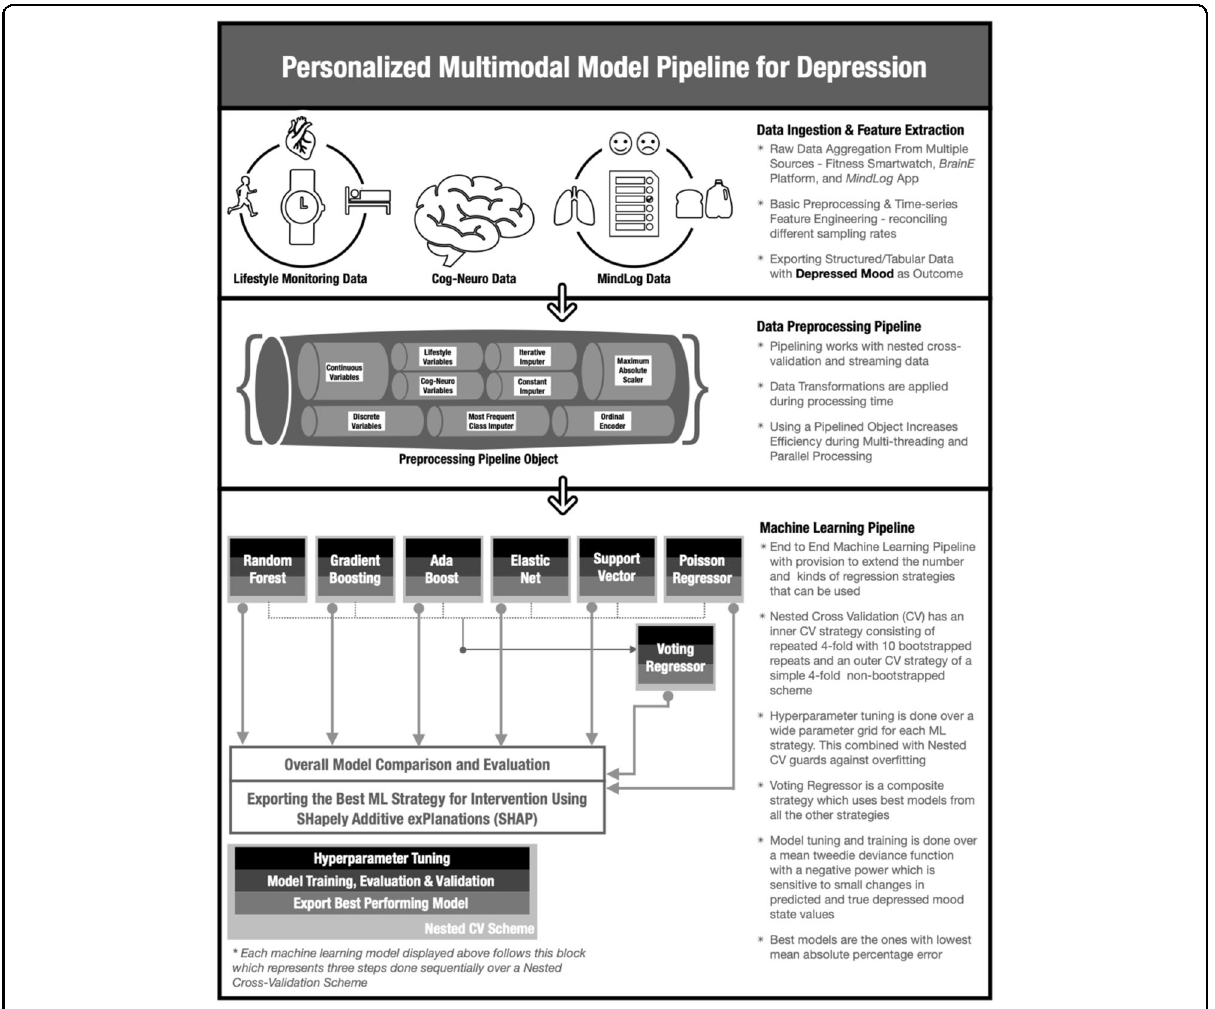
Fig. 1 Summary of the three main steps involved in the personalized depression modeling pipeline, namely, data ingestion and feature extraction, data preprocessing, and machine learning-based analysis. These steps were carried out separately for each subject and personalized performance reports, prediction reports, and feature importance reports were